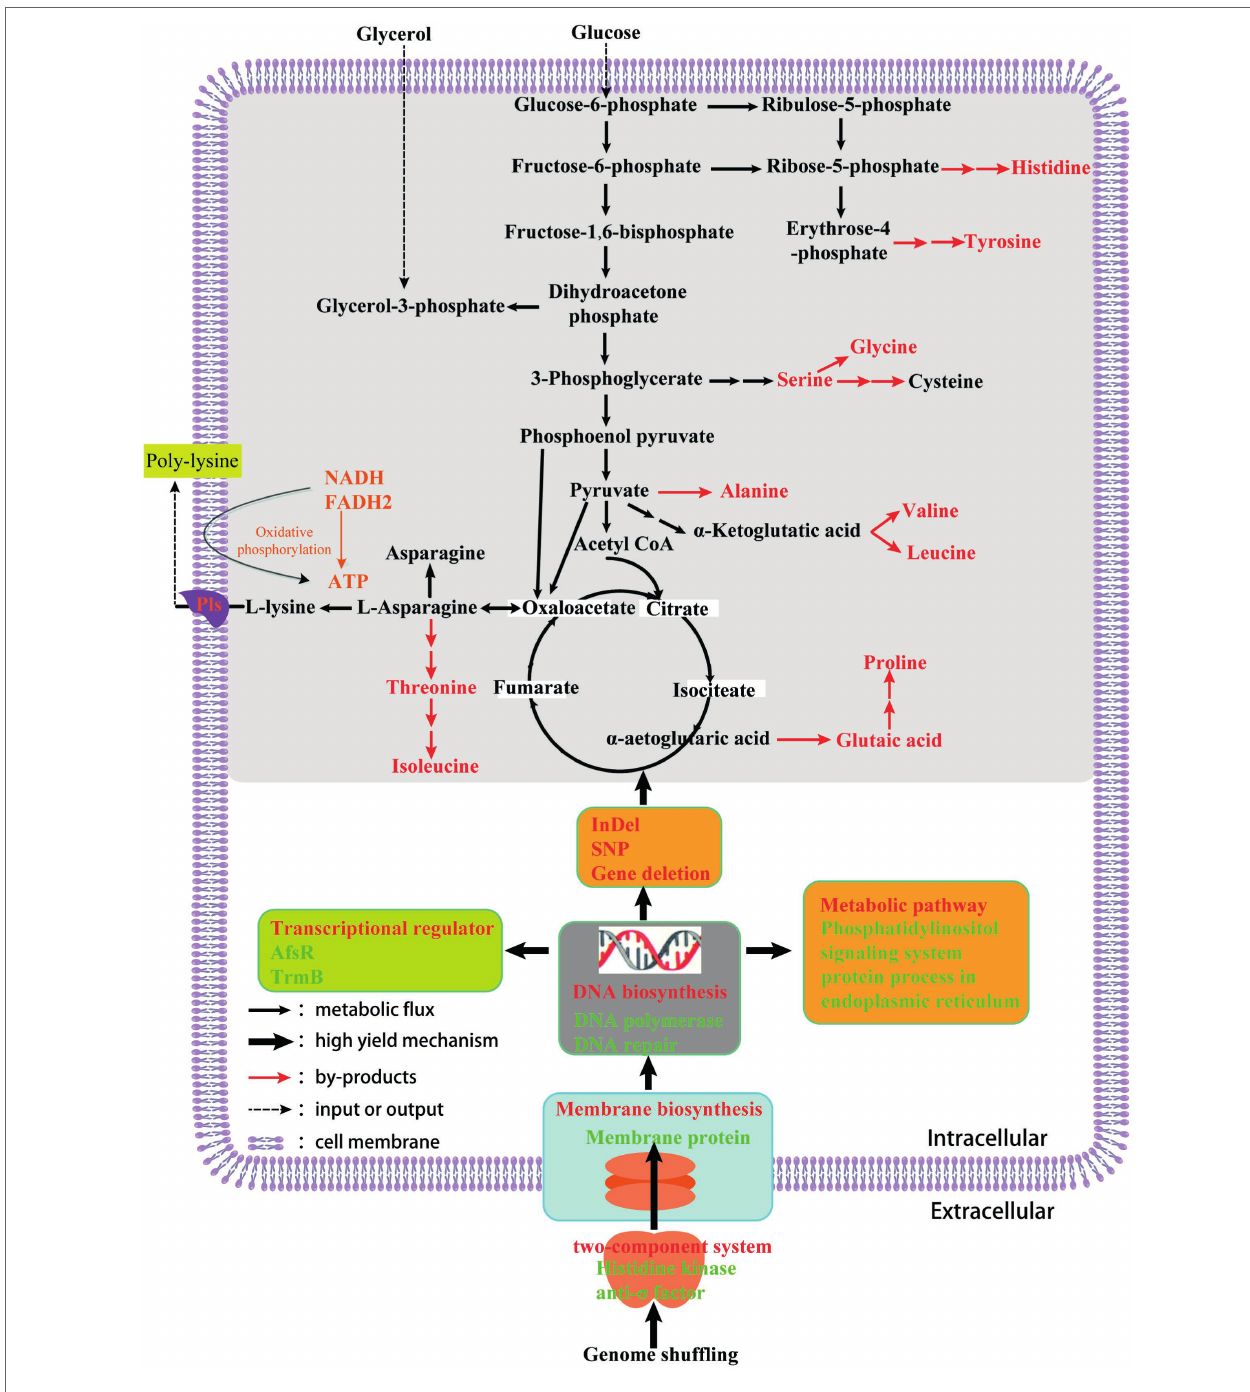
FIGURE 6 | High-yielding mechanism of ε -PL from S. albulus using genome